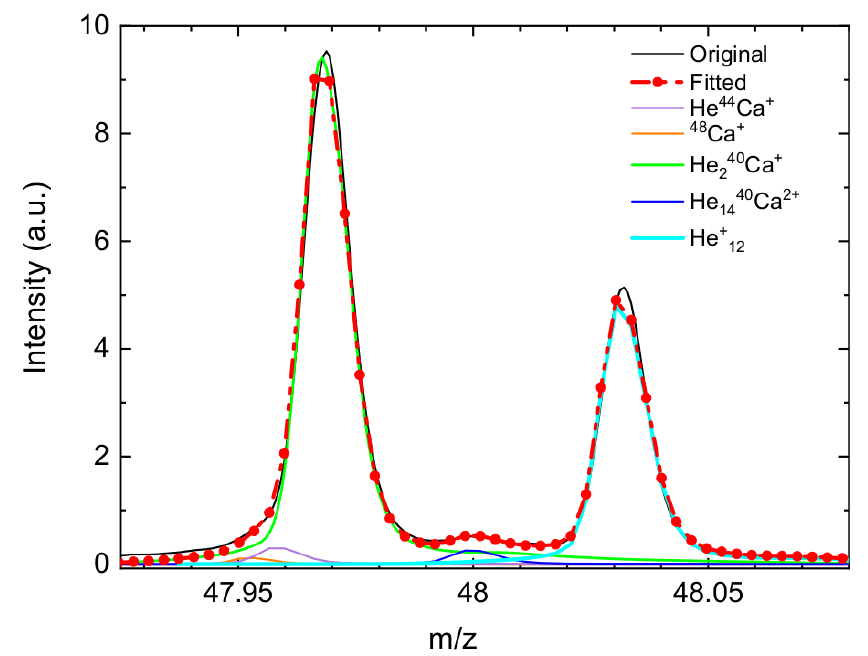
Figure 2. Well resolved mass spectra (arb. units) around the mass-to-charge ratio m / z = 48 showing the contribution of cations that have to be considered for fitting the measured